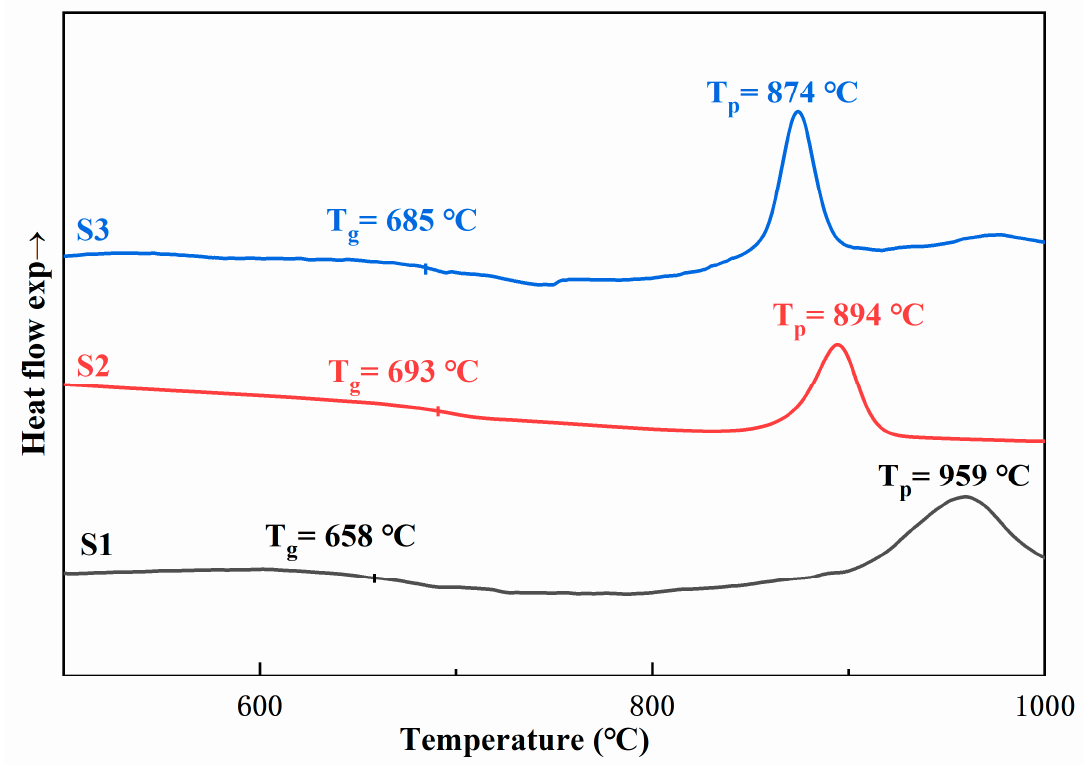
Figure 1. Di ff erential scanning calorimetry (DSC) curve recorded for the glass Figure 1. Differential scanning calorimetry (DSC) curve recorded for the glass matrix.